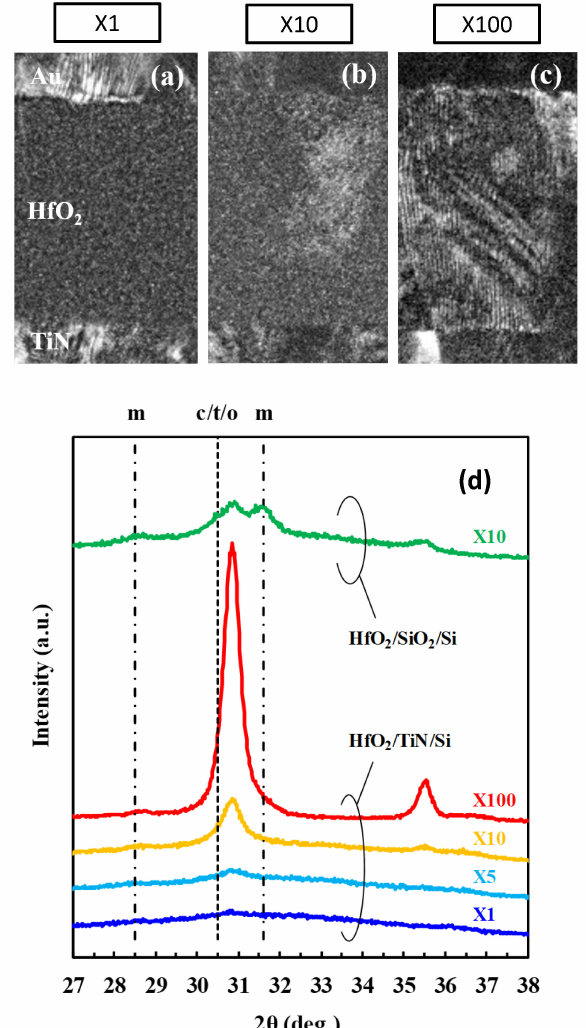
Figure 20. ( a – c ) Cross-sectional dark-field TEM images and ( d ) XRD patterns taken on 50 nm thick HfO 2 /TiN/Si samples after single or multiple ns UV-LA processing. Reprinted/adjusted with permission from Ref. [101]. 2020, The Japan Society of Applied